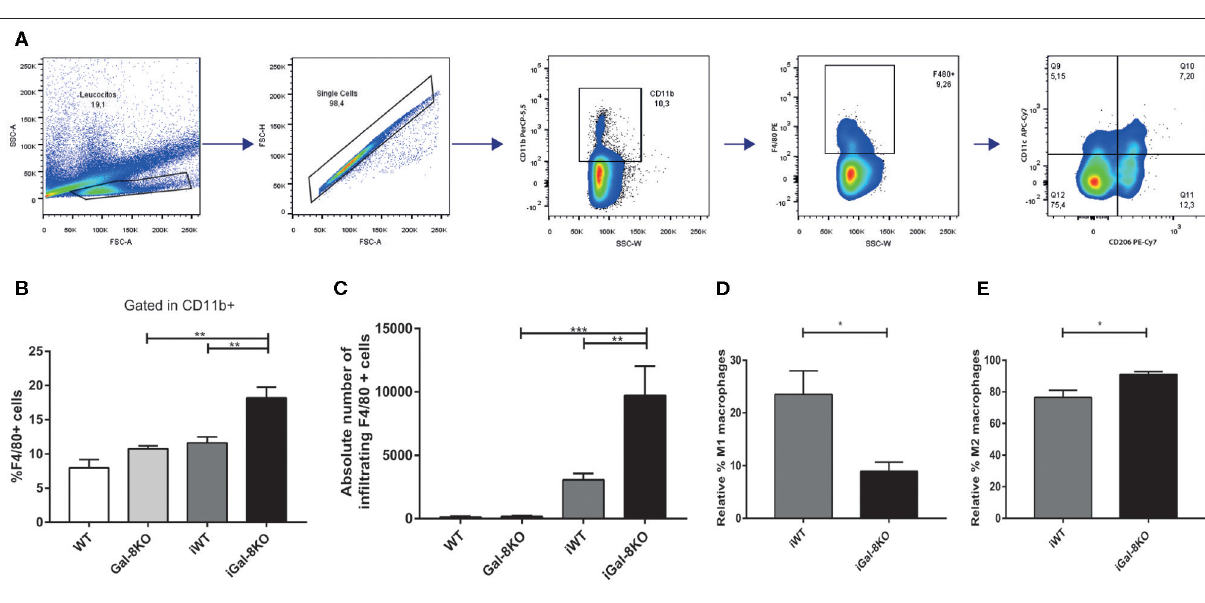
Frontiers in Cellular and Infection Microbiology |